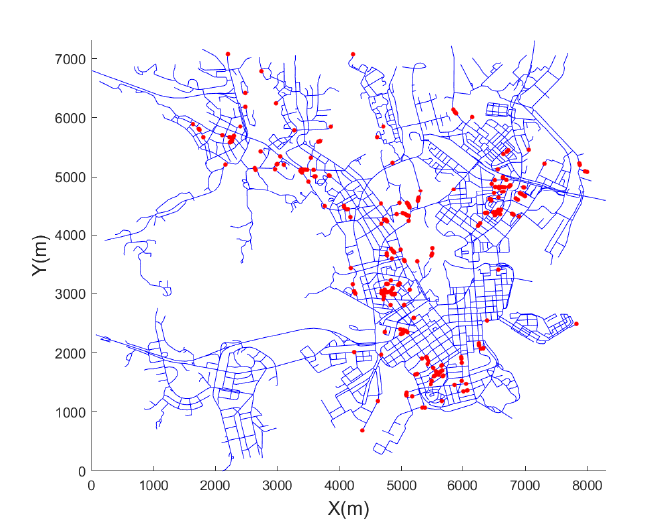
Figure 9. Generated spots on the real road map of Helsinki